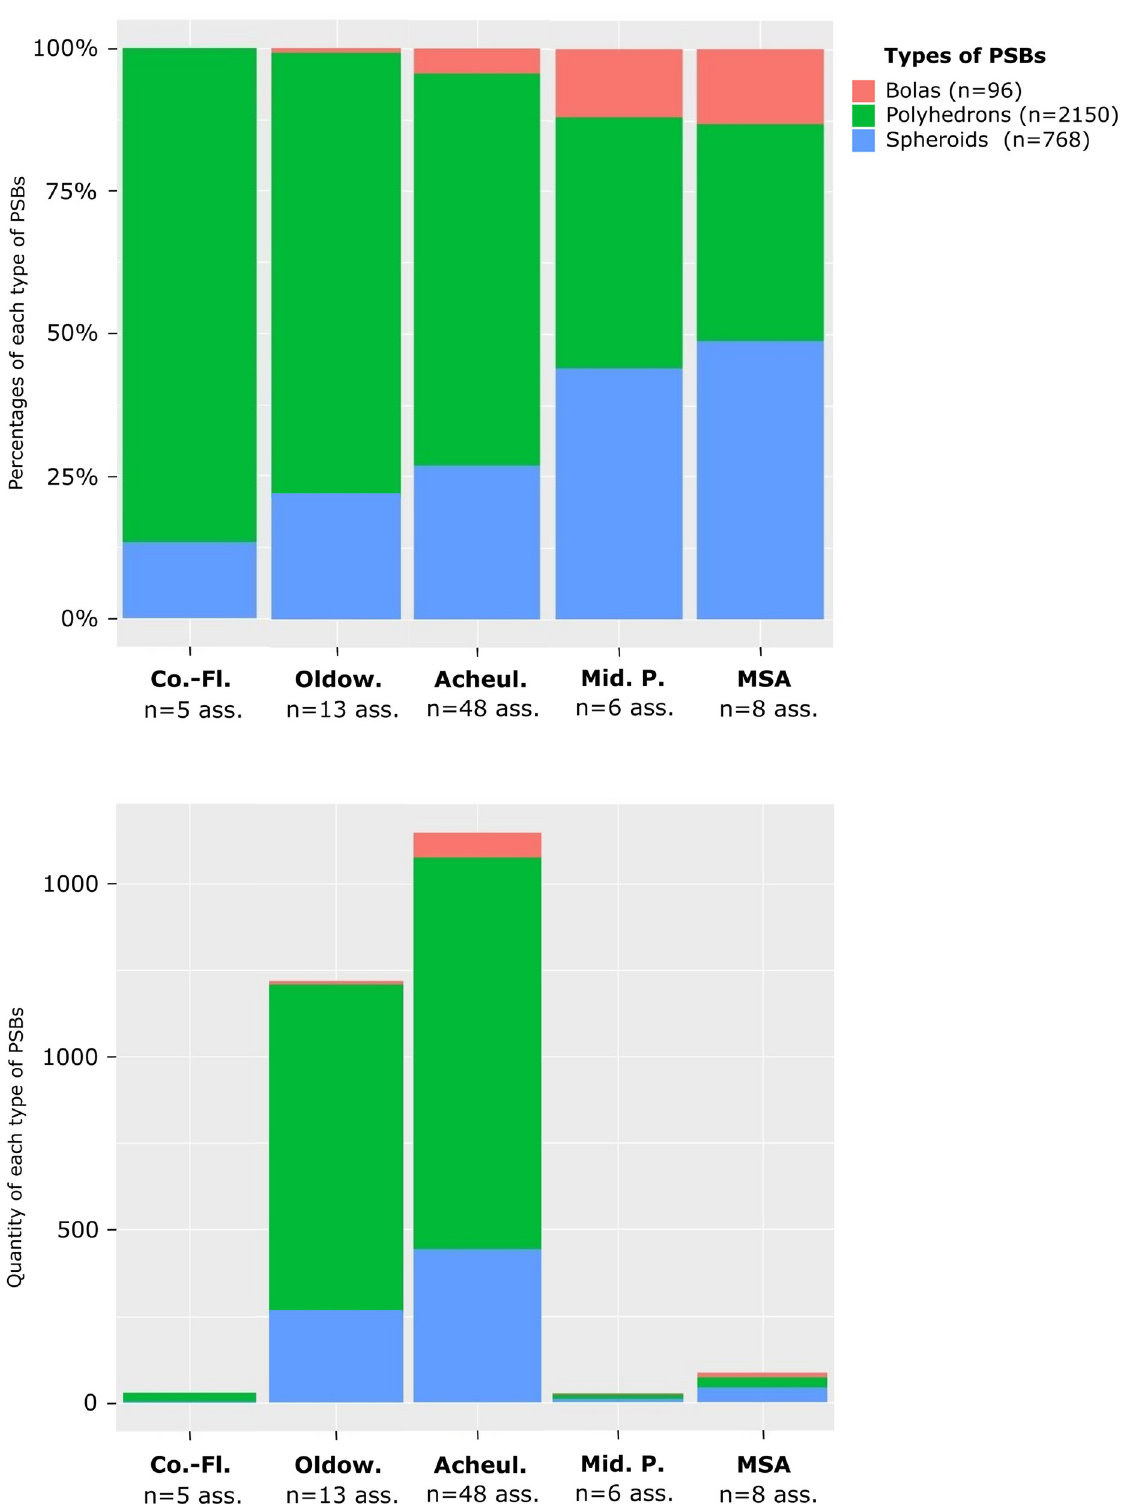
Fig 6. Frequencies and quantities of polyhedrons, spheroids and bolas in assemblages according to chrono-cultural attributions. Oldow.: Oldowan. Co.-Fl.: Core-and-Flake. Acheul.: Acheulian. Mid. P.: Middle Palaeolithic. Ass.: assemblages.